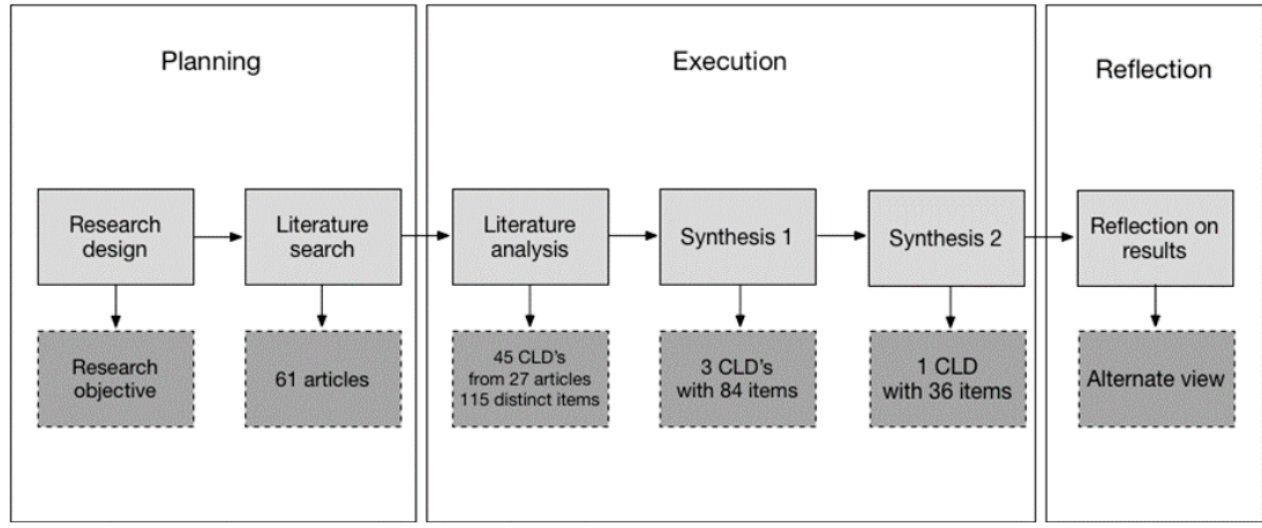
Figure 1. The three stages of the research process.